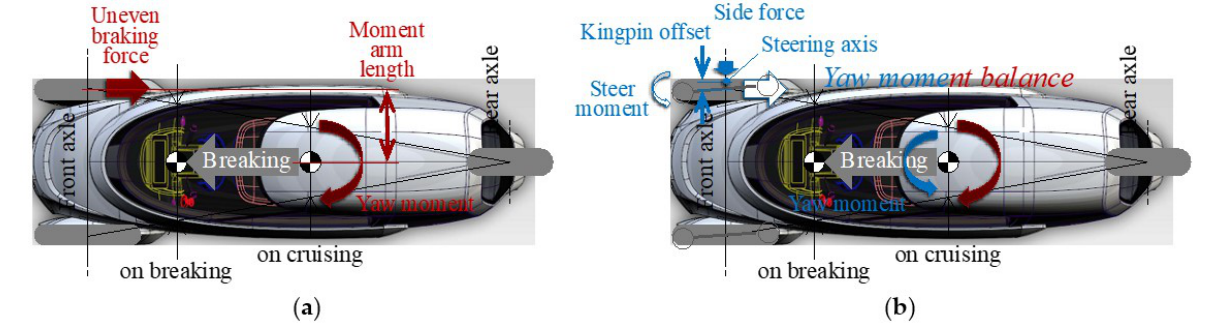
Figure 6. ( a ) Yaw moment on uneven braking force. ( b ) Yaw moment balance on uneven braking force.